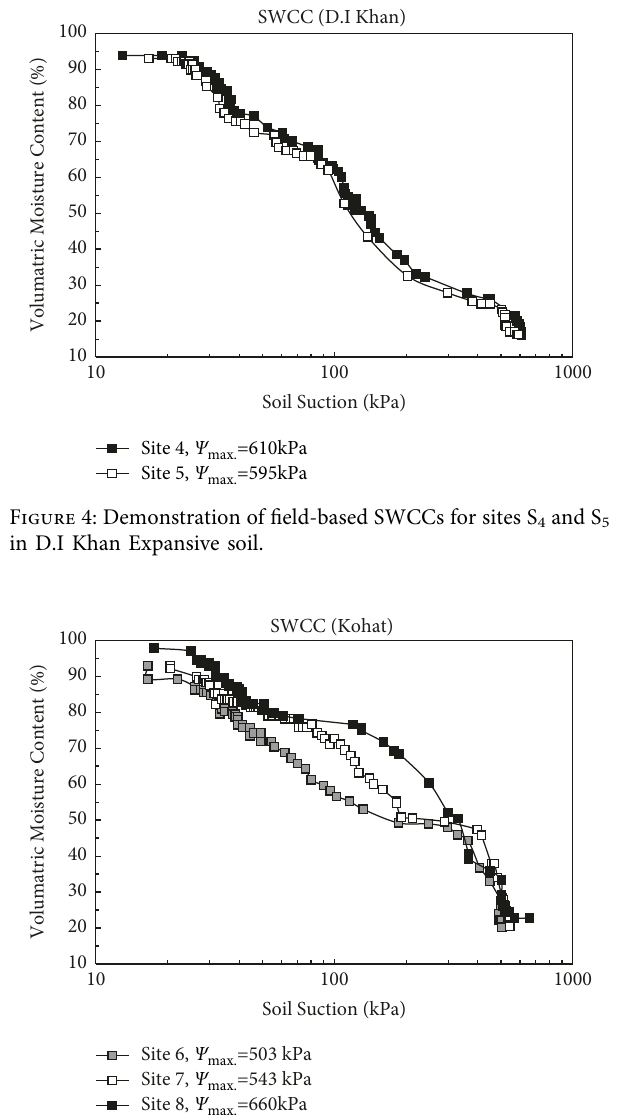
6 , S 7, and S 8 in Kohat’s